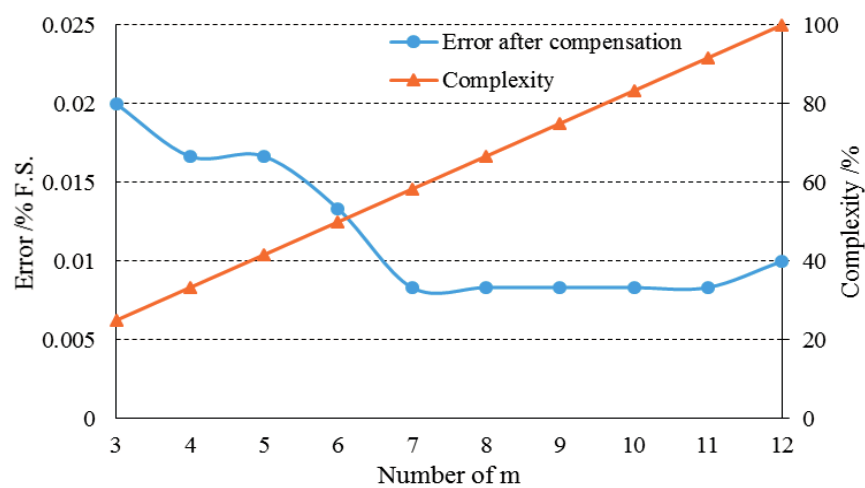
Figure 4. The selection of calibration points has an influence on the compensation error. M = 7 is the optimal calibration points of temperature, which maintains a high accuracy and reduces the complexity by 41% compared to the case of m = 12.